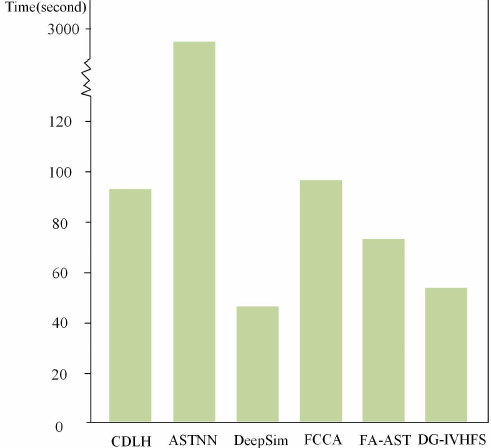
Figure 9. Time consumption of our model based on dual graph convolutional networks and interval- valued hesitant fuzzy set, as well as other baseline models in the prediction